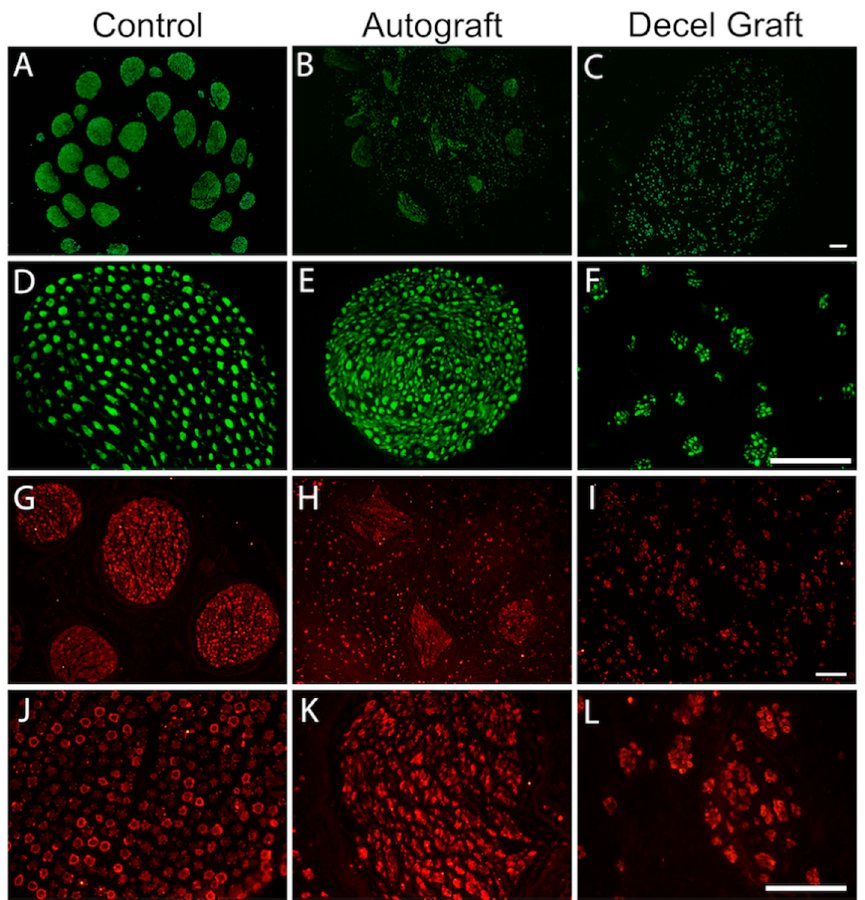
Figure 7. Representative micrographs showing immunofluorescence of myelinated axons labeled against Neurofilament 200 in cross sections of the proximal graft in AG and DC groups. ( A , D ) control nerve, ( B , E ) autograft and ( C , F ) decellularized nerve graft. A , B , C scale bar 200 µ m, and D , E , F scale bar 100 µ m. Representative micrographs showing immunofluorescence labeling of Schwann cells with an antibody against the S100 protein in cross sections of the proximal graft in AG and DC groups. ( G , J ) control nerve, ( H , K ) autograft and ( I , L ) decellularized nerve graft. G , H , I scale bar 100 µ m, and J , K , L scale bar 100 µ